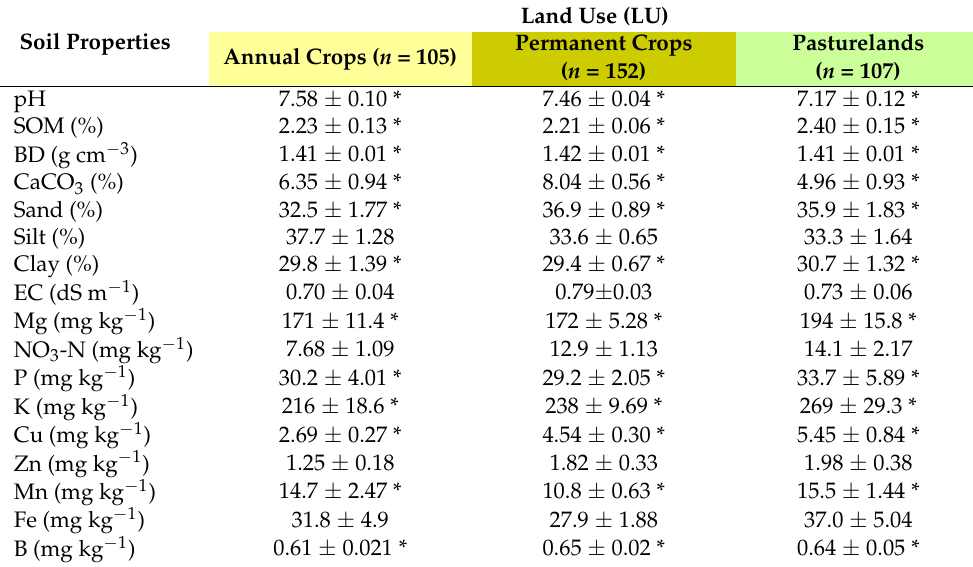
Table 4. Least square means with standard error (SE) of soil chemical and physical parameters in different land uses (LU).